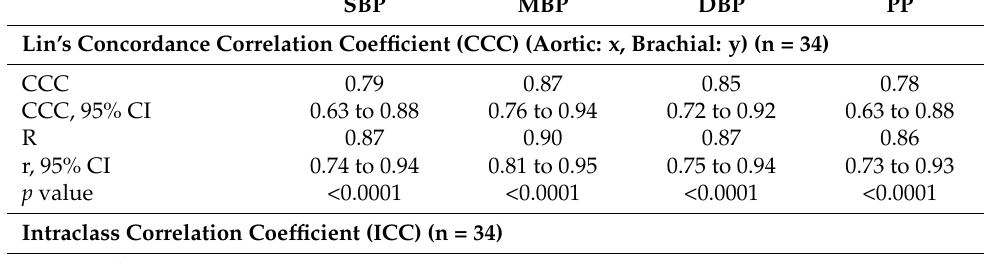
Table 3. Comparison between invasive brachial artery and aortic blood pressure. SBP MBP DBP